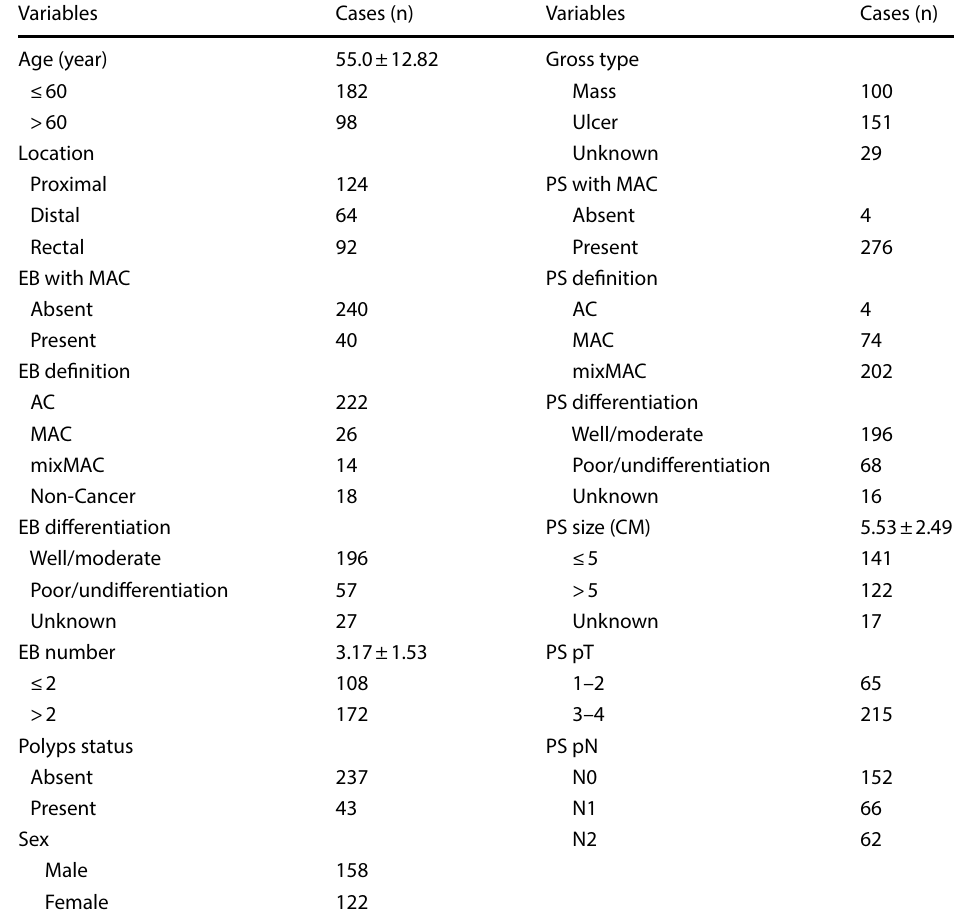
Table 1 The baseline characteristics of colorectal MAC patients from Changsha